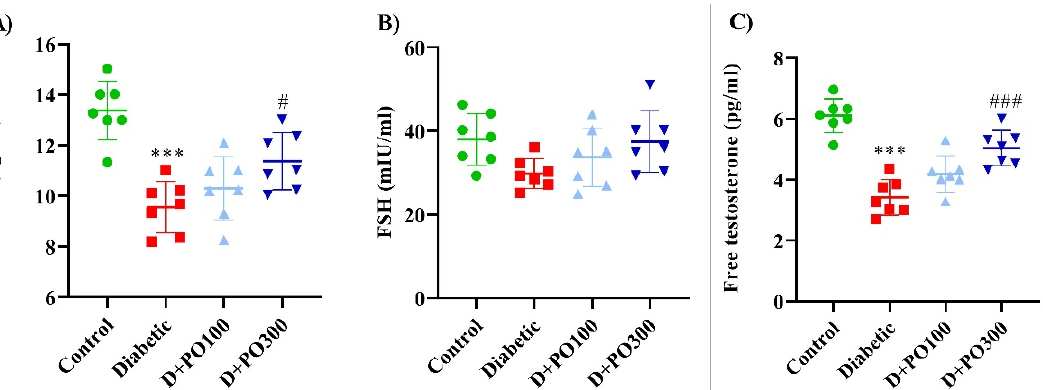
Figure 10. The effects of PO extract on ( A ) LH, ( B ) FSH, and ( C ) testosterone levels in diabetic rats. The data are presented as mean ± SD. A one-way ANOVA test was carried out with the following Tukey–Kramer’s post hoc test; *** p < 0.001 vs. control group; # p < 0.05, ### p < 0.001 vs. diabetic group.